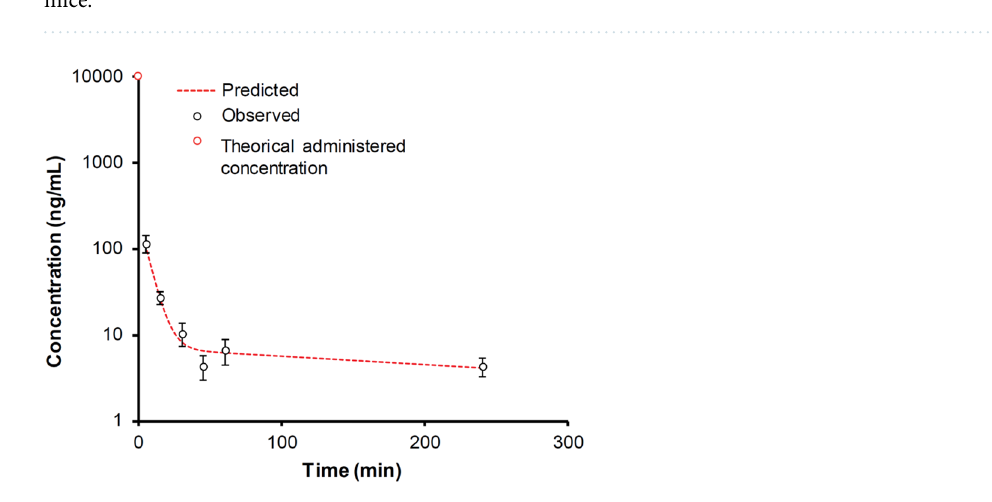
Figure 3. Pharmacokinetic profile of AuNPd (1 mg/kg) at 5, 15, 30, 45, 60 min and 4 h after a single intravenous administration (n = 5, data are mean ± SEM). A point for 0 minute corresponds to theoretical administered concentration (10 000 ng/ml).